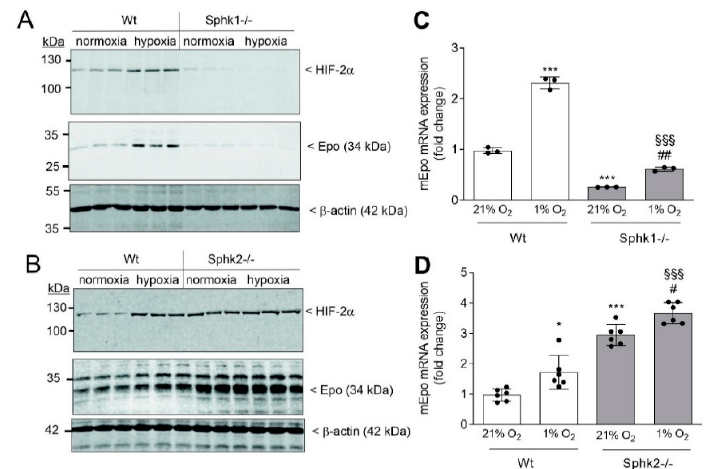
Figure 4: Sphk1 and Sphk2 deficiency affects hypoxia-induced HIF-2 α and Epo protein and mRNA expression in primary cultures of fibroblasts. Sphk1 − / − ( A ), or Sphk2 − / − ( B ) mouse kidney fibroblasts were incubated for 16 h in serum-free DMEM prior to exposure for 6 h to normoxia (21% oxygen) or hypoxia (1% oxygen). Protein was analyzed by immunoblotting using antibodies against HIF-2 α (top panels), Epo (middle panels), or β -actin (bottom panels). Corresponding bands were evaluated by using Image Studio Lite software (version 3.1, LI-COR Biosciences, Lincoln, NE, USA), normal- ized to β -actin, and are presented in Figure S6. mRNA ( C , D ) was quantified by qPCR using primers for mouse Epo, or L28 mRNA for normalization. Results are expressed as fold change and are means ± S.D. ( n = 3 or 6); * p < 0.05, *** p < 0.001 were considered statistically significant when compared to the normoxic Ctrl cells; # p < 0.05, ## p < 0.01 compared to the Sphk1 − / − or Sphk2 − / − normoxic cells; §§§ p < 0.001 compared to the respective hypoxic Ctrl cells.